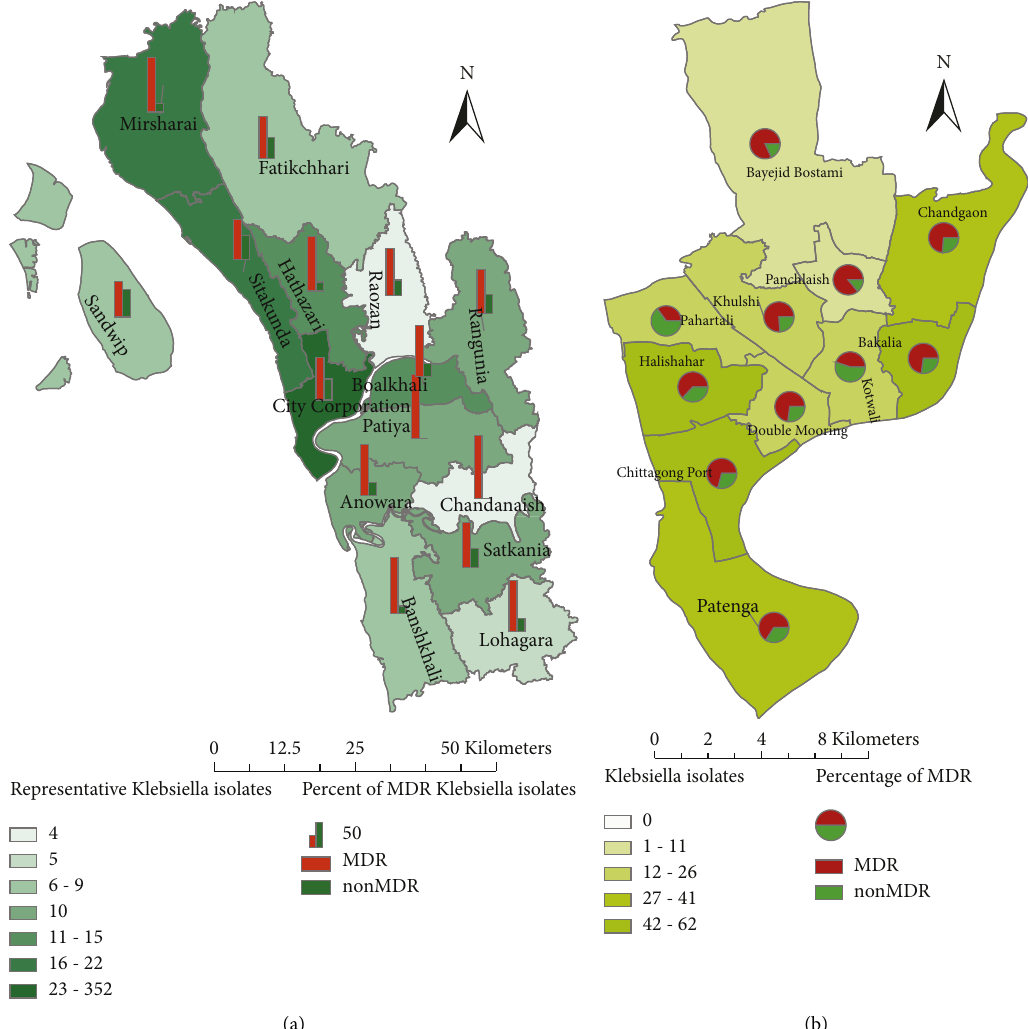
Figure 1: Spatial distribution of antibiotic resistance of Kpn isolates among the patients of Chattogram. (a) Rural area; (b) Urban area (Chittagong City